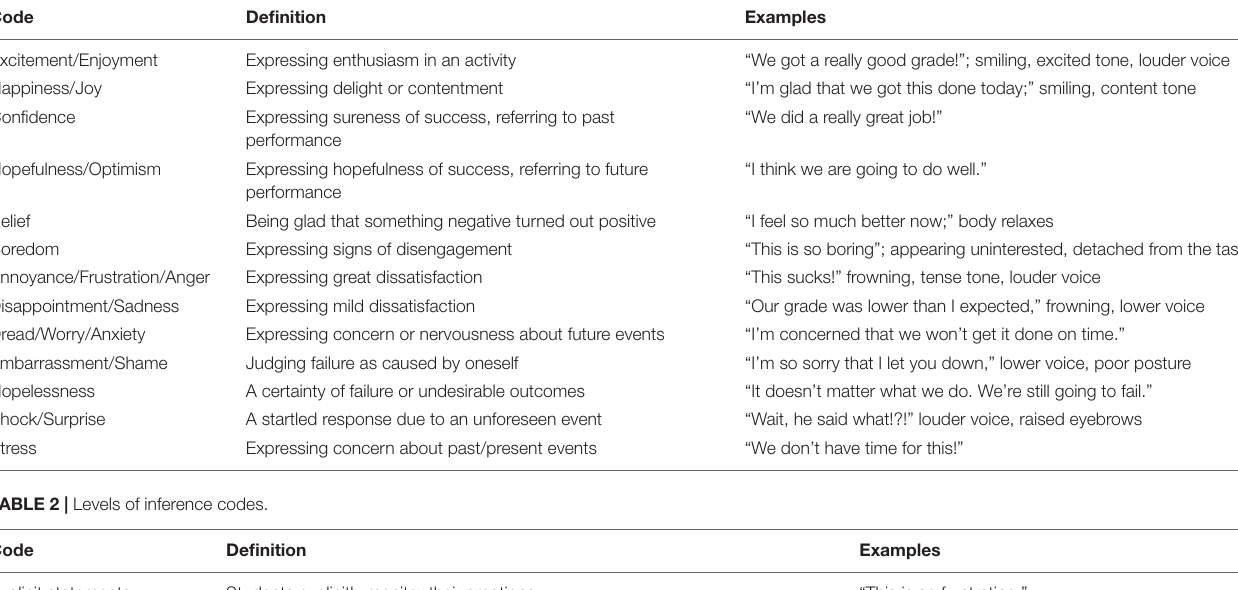
TABLE 1 | Emotional expressions codes.